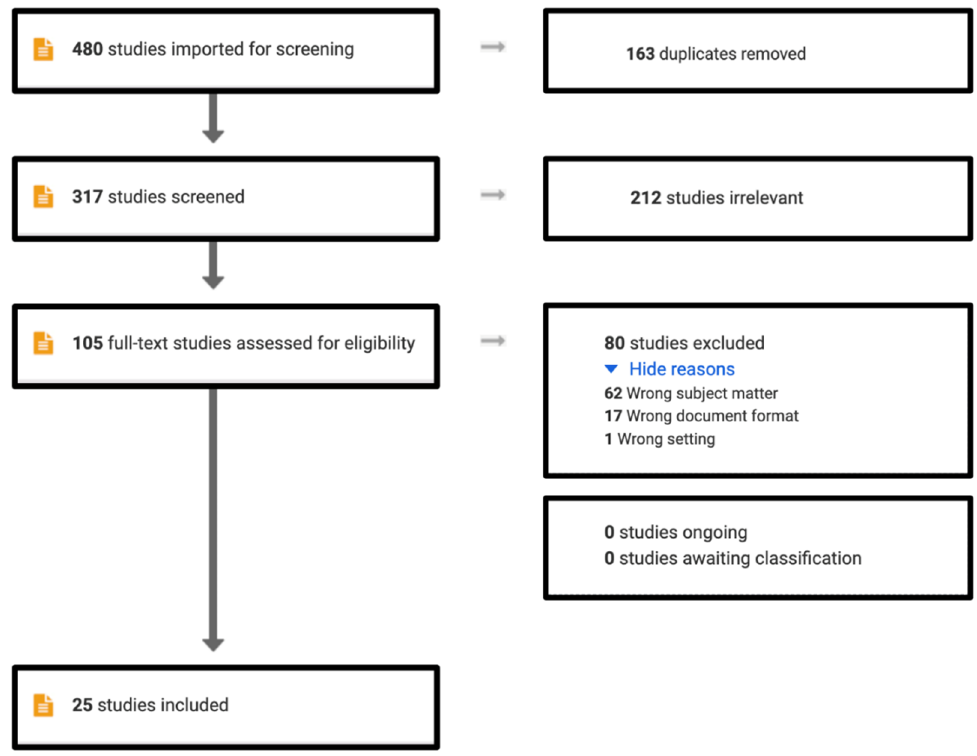
Figure 3. PRISMA diagram for review of literature in PubMed, Scopus, and Embase databases for the present